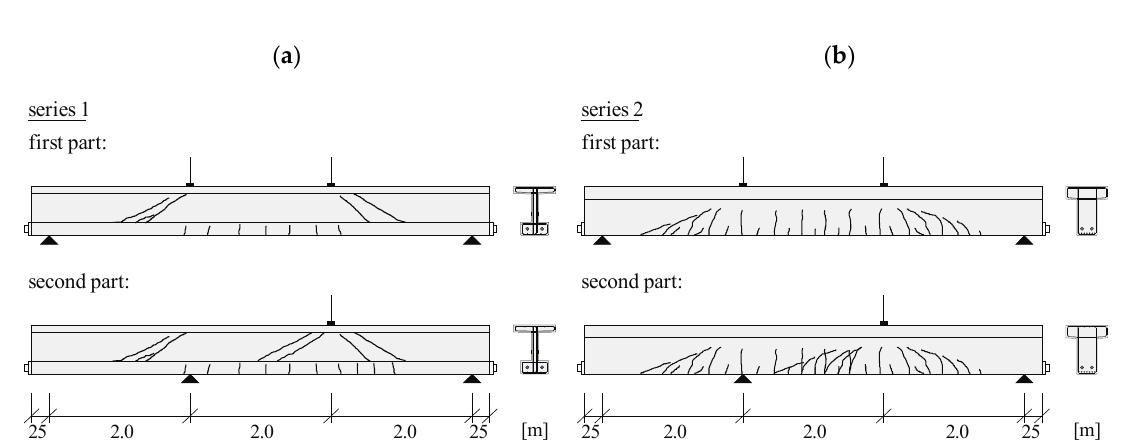
Figure 1. Experimental test setups with typical crack patterns ( a ) series 1: I-beam; ( b ) series 2: T-beam. With an axial distance of 9.5 cm from the bottom side of the beam, two straight tendons (each 3Ø0.6” (1.4 cm 2 )) were arranged for post-tensioning (St 1570/1770, f p0.1k = 1500 N/mm 2 ). After the subtraction of all losses, the prestressing force for the beams varied between 330 kN and 500 kN (Table 1). The mean strengths of the ready mixed concrete during the test period were in a range of 32 and 48 N/mm 2 over all tests with a small variation over the test period of each beam (Table 2).